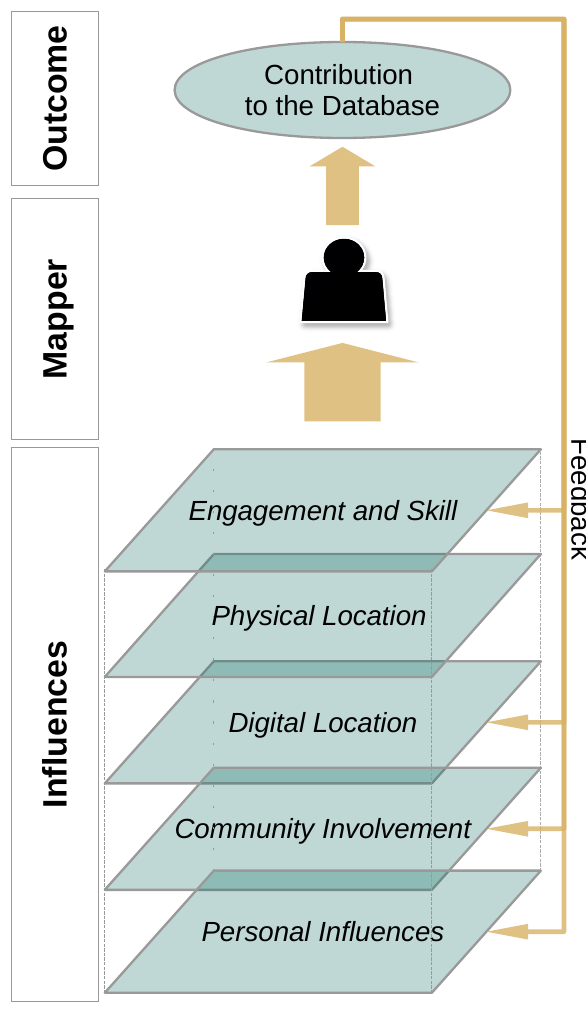
Figure 1. Influences or context a mapper is exposed to while making a contribution, i.e., characteristics of a